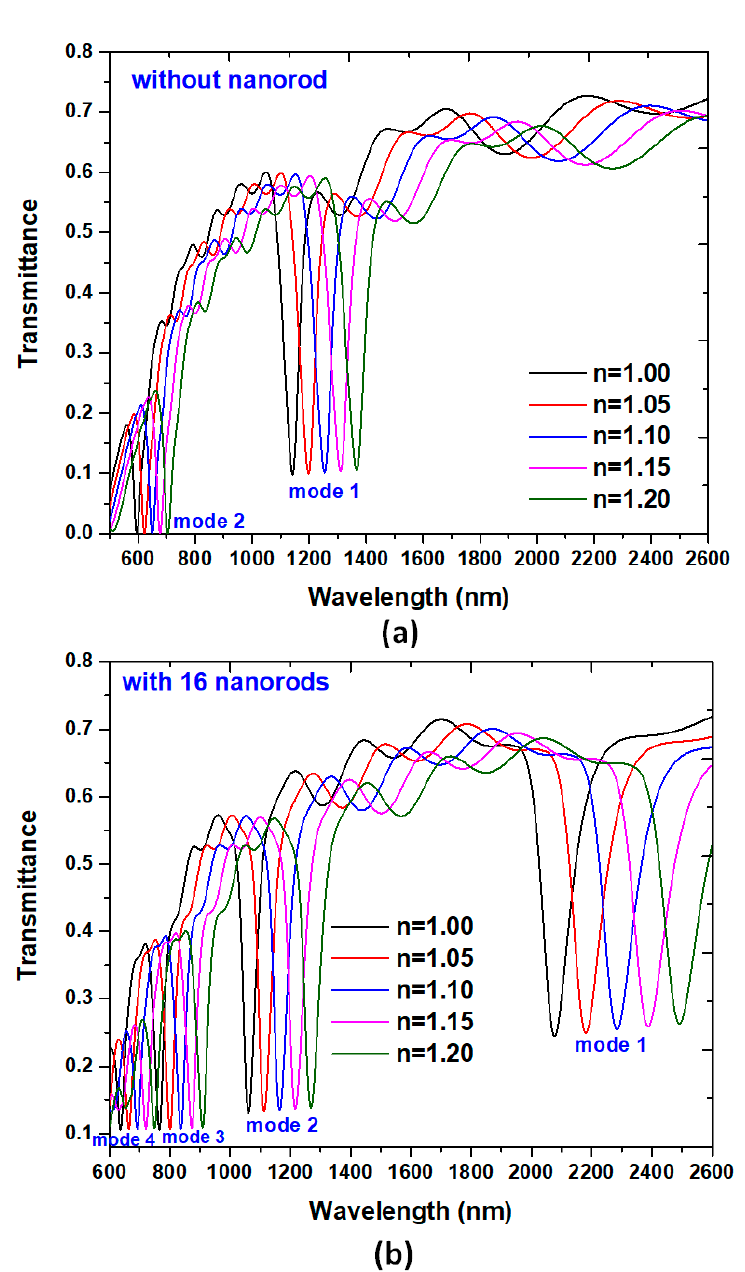
Figure 4. Transmittance spectra of the proposed plasmonic band-stop filter ( a ) without and ( b ) with 16 silver nanorods in the nanoring. The refractive index of the material under sensing, n , is assumed to be 1.0, 1.05, 1.10, 1.15, and 1.20, respectively. The other geometric parameters, w , h , R , and r , are set to be 50, 10, 100, and 20 nm, respectively.